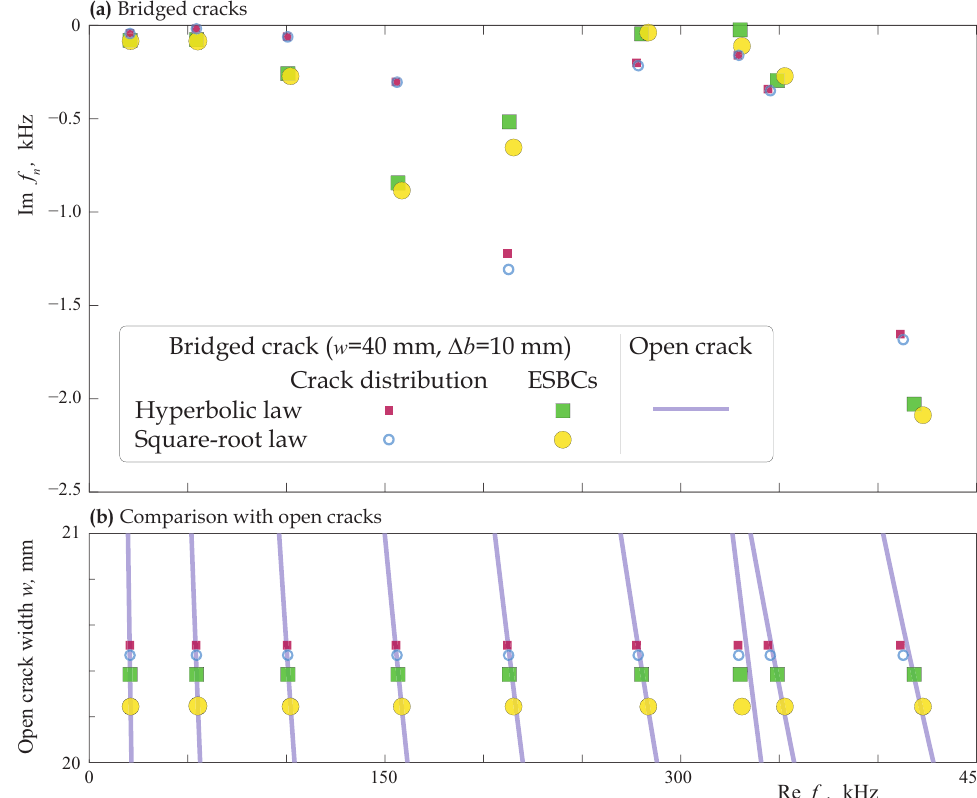
Figure 18. Eigenfrequencies f n ( w ) of the laminate with an open crack ( a ) and eigenfrequencies f n of the laminate with an interfacial bridged crack of length w = 40 mm with two bridged zones of ∆ b = 10 mm modelled as an array of cracks and via the ESBCs using the hyperbolic and square-root laws ( b